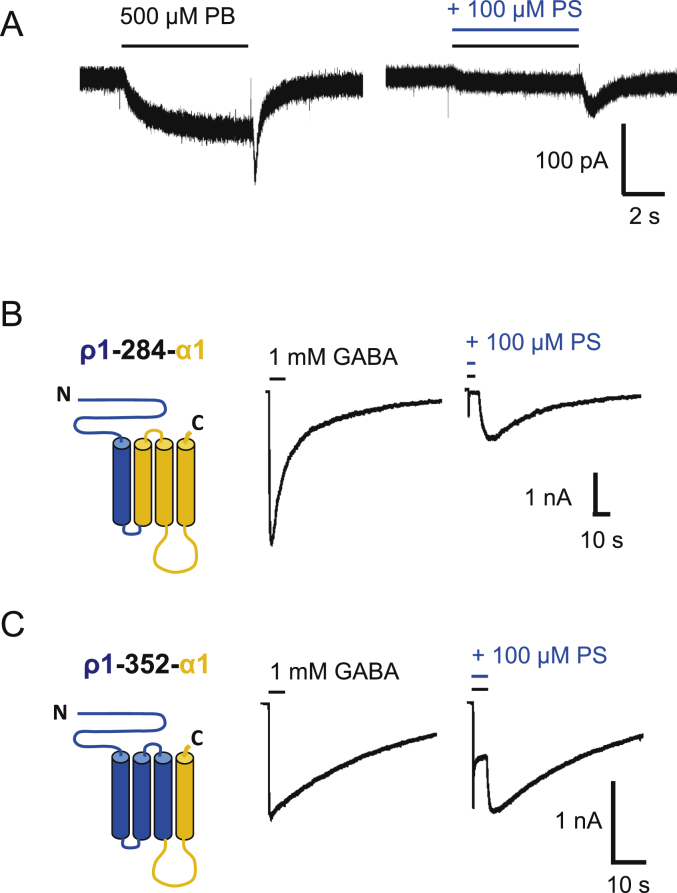
PS inhibition of pentobarbitone (PB) currents at β3 homomers and of GABA currents at TMD chimeras.(A) Membrane currents activated by 500 μM PB at the β3 homomer before (left) and after co-application of 100 μM PS. Note the fast inward rebound current after wash-off of PB and its inhibition by PS. (B) Left panel shows schematic of the transmembrane topology for the ρ1-284-α1 chimera. The ECD, M1 and M1-M2 linker are from the ρ1 subunit (blue), whilst the rest of the chimera is taken from α1 (orange). Right panel shows representative 1 mM GABA currents before and after co-application of 100 μM PS. (C) Left panel shows schematic of the ρ1-352-α1 chimera. The ECD and TMD residues up to the C-terminal end of M3 are taken from ρ1 (blue), whereas the M3-M4 linker and M4 and C-terminal tail are from α1. Right panel shows 1 mM GABA currents and their inhibition by 100 μM PS. At least three independent recordings were performed for each chimera. Note the profound desensitisation and rebound currents.